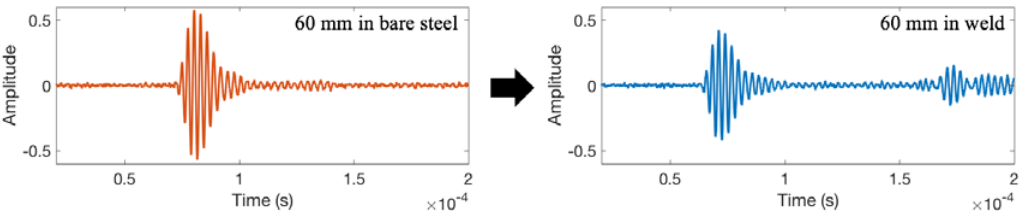
Figure 9. The comparison of the time domain waveforms for the signal with a travel distance of 60 mm in bare steel vs weld coupon No. 1.